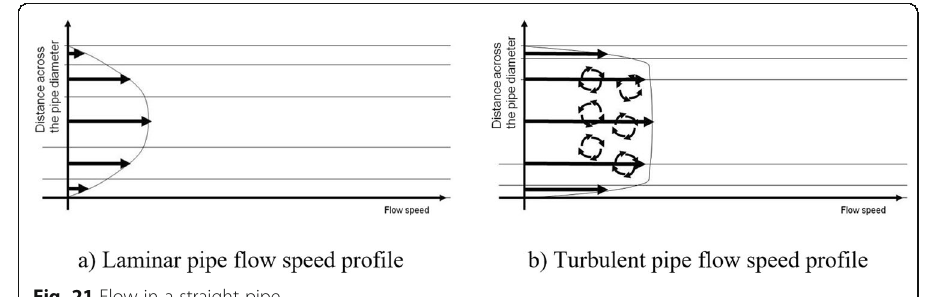
Fig. 21 Flow in a straight pipe